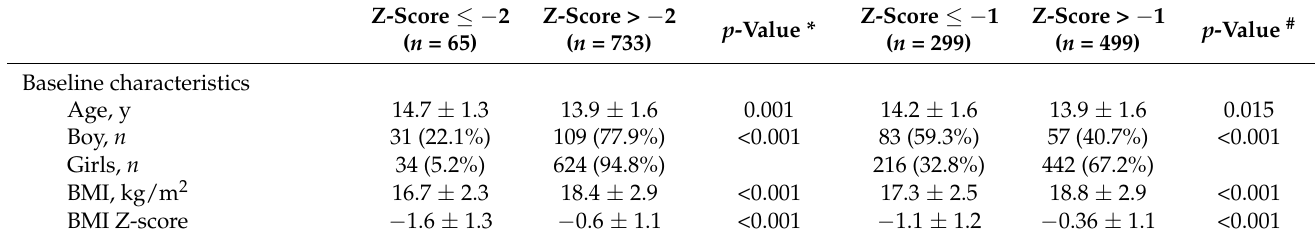
p -value* indicates p -value of the comparison between AIS girls and boys. Mean ± SD* indicates that continuous variables were presented as mean ± standard deviation (SD). BMI, body mass index;